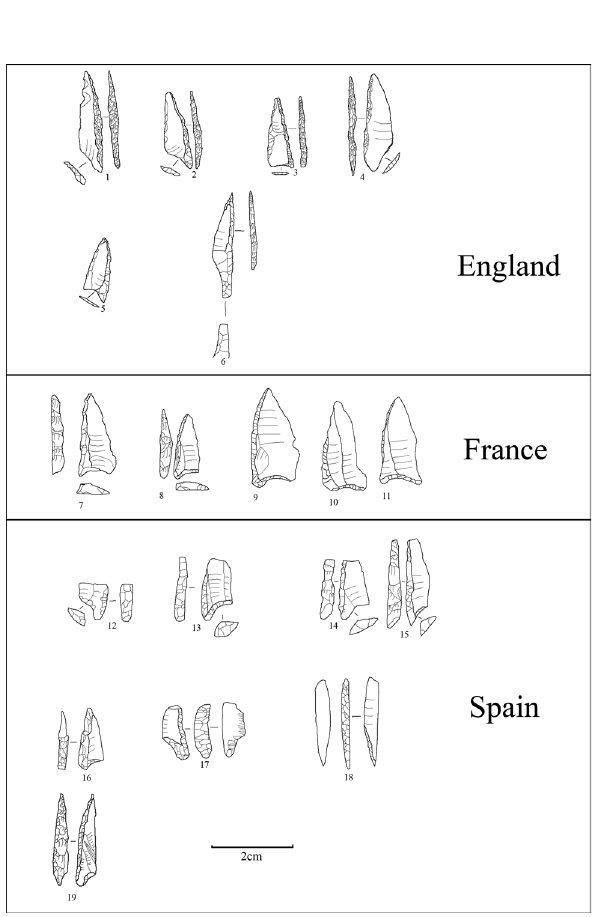
Figure 6: Bexhill points from SE England and Bexhill - esque points from N. Spain and NW France: ( 1 – 4 ) Bexhill; ( 5 ) North Park Farm; ( 6 ) Charlwood; ( 7 – 8 ) Saint Gildas 1c; ( 9 – 11 ) Hoëdic; ( 12 – 13 ) El Mazo; ( 14 – 15 ) Mendandia; ( 16 ) la Una; ( 17 ) Aizpea II; ( 18 ) Kobaederra; ( 19 ) Aizpea III. Redrawn from: ( Alday, 2005, 2014; Alday & Cava, 2008; Campos, Fuertes, & Alonso, 2016; Cubas et al., 2016; Dupont, Marchand, Gruet, & Tessier, 2007; Ellaby, 2004; Fuertes - Prieto et al., 2021; Jones, 2013; Péquart & Péquart, 1954 )